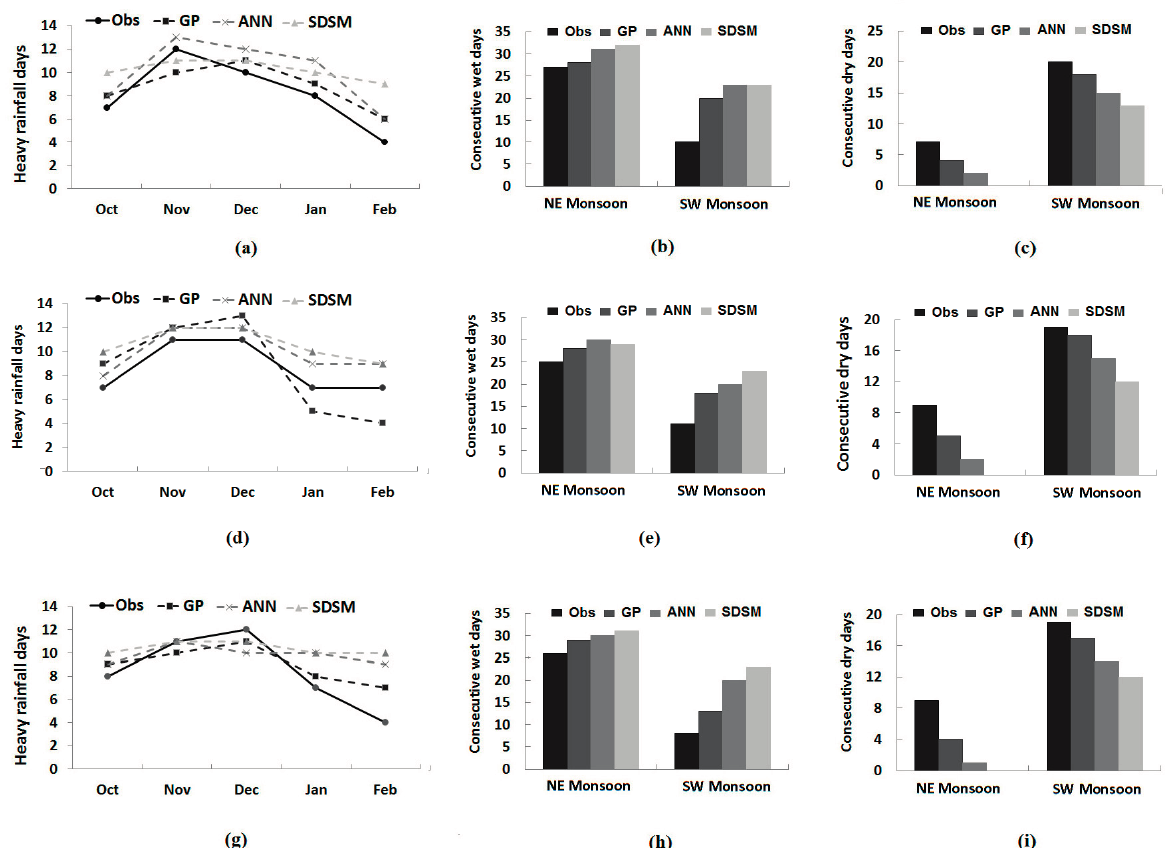
Figure 9. Monthly/seasonal distribution of: ( a ) heavy rainfall days, ( b ) consecutive wet days and ( c ) consecutive dry days at Besut; ( d ) heavy rainfall days; ( e ) consecutive wet days and ( f ) consecutive dry days at Dungun; and ( g ) heavy rainfall days, ( h ) consecutive wet days and ( i ) consecutive dry days at Kemaman.